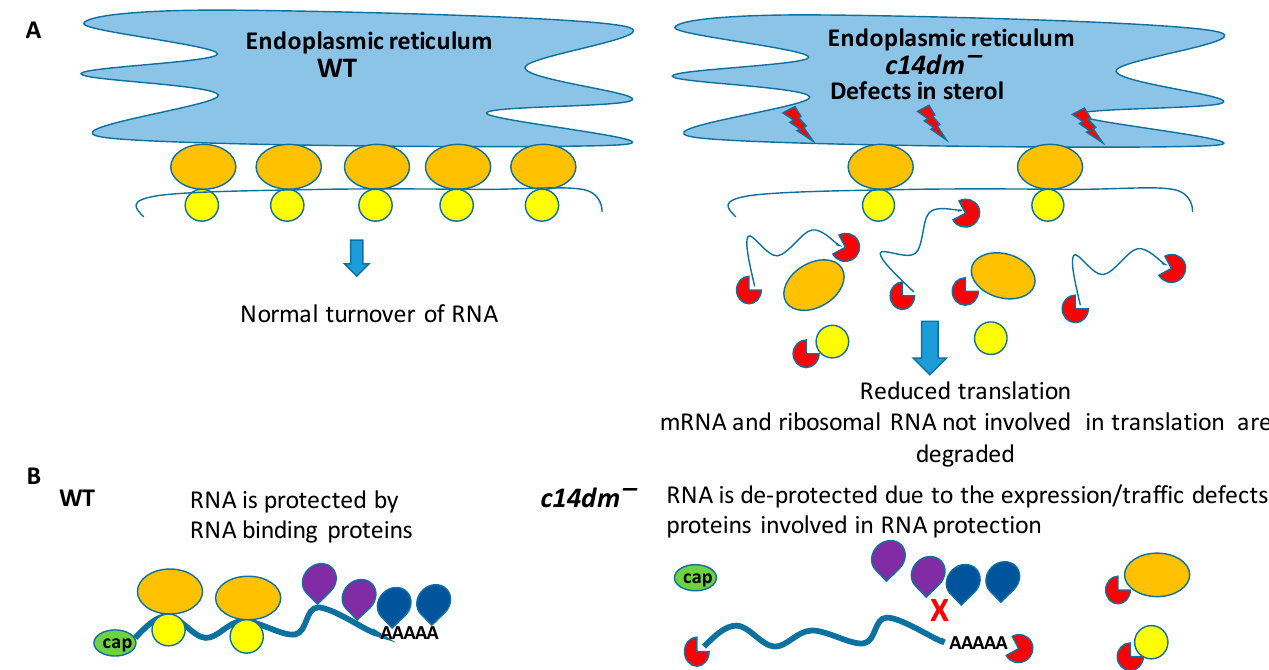
Figure 10. A model depicting the putative mechanism of RNA reduction in c14dm − . ( A ) Sterol synthesis defects may alter the lipid content of the ER and reduce ribosome recruitment, causing degradation of rRNA and mRNA not involved in translation. ( B ) Alternatively, defects in sterol synthesis may cause traffic defects preventing proteins involved in RNA protection from reaching and protecting RNA. Lightning bolts in red depict defects in sterol. Small (yellow) and large (orange) ovals represent small and large subunits of ribosomes, respectively. mRNA is shown as a blue line. Enzymes involved in RNA degradation are shown as partial red circles. RNA-binding proteins are shown in blue and purple.